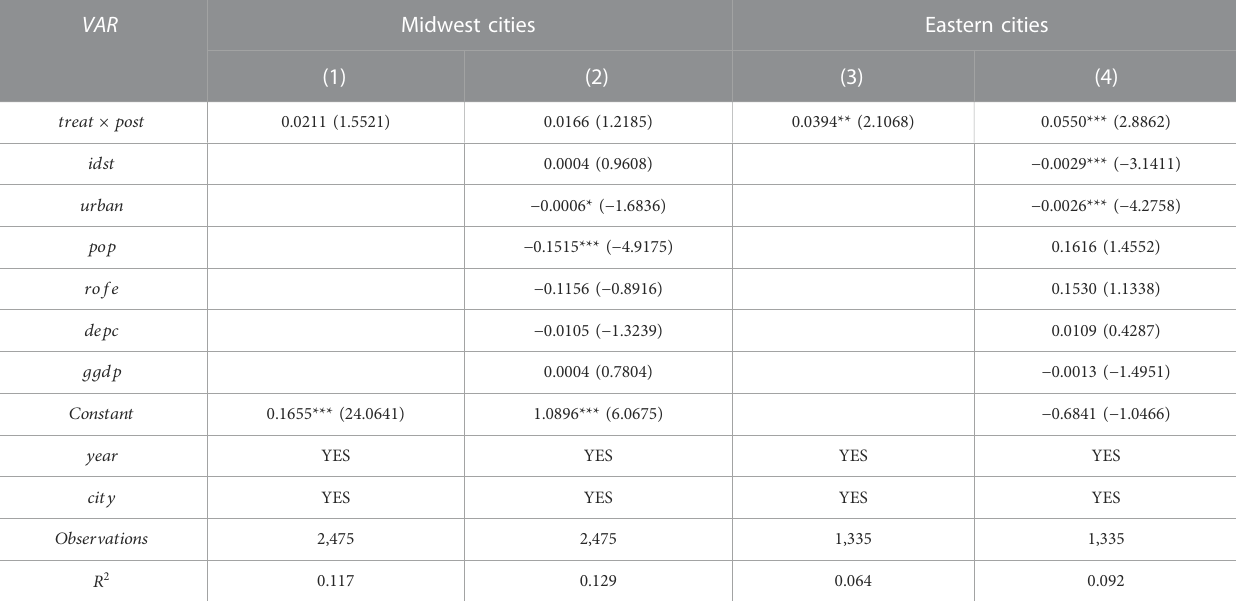
TABLE 5 Heterogeneity